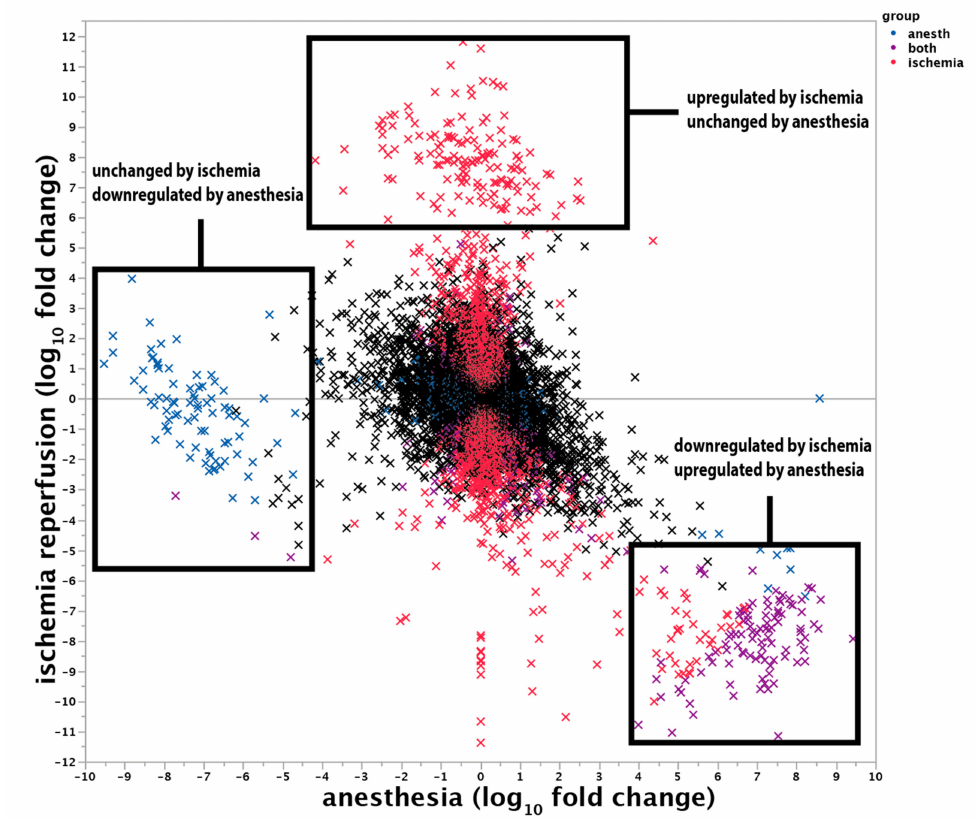
Figure 8. Respective effects of ischemia and anaesthesia on the renal transcriptome. The y -axis shows the fold change in the mRNA expression of ischemic kidneys compared to control kidneys, and the x -axis shows the fold change in the mRNA expression of ischemic kidneys under anaesthesia vs. ischemic kidneys in conscious mice. The statistical analysis is described in the Materials and Methods